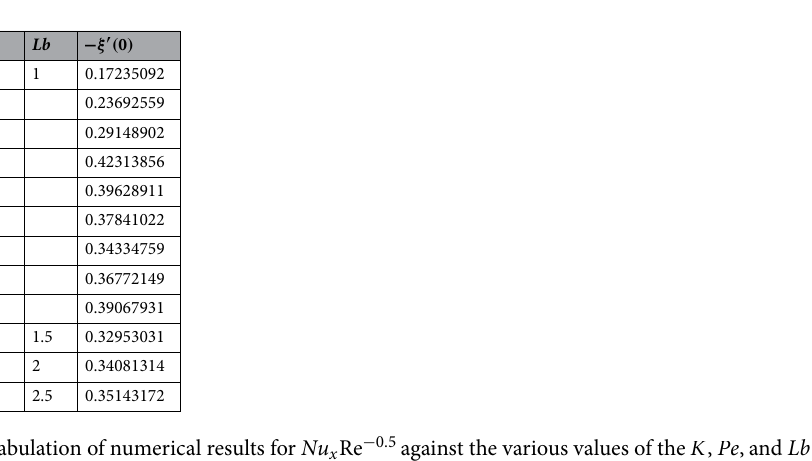
Table 4. The tabulation of numerical results for Nu x Re − 0.5 against the various values of the K , Pe , and Lb